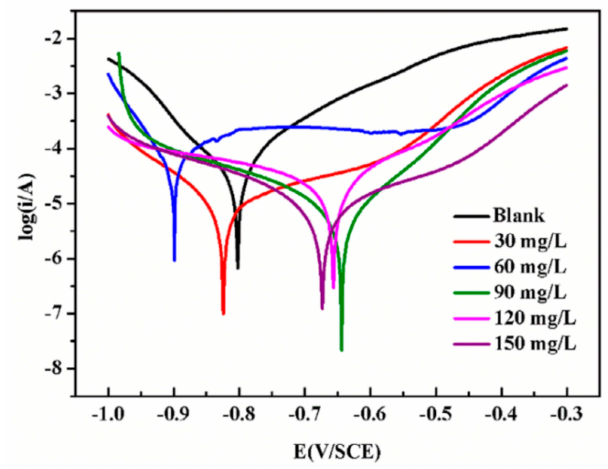
Figure 11. Potentiodynamic polarization curves recorded for the carbon steel electrode in 3 wt % NaCl solution containing different concentrations of HBP − 3